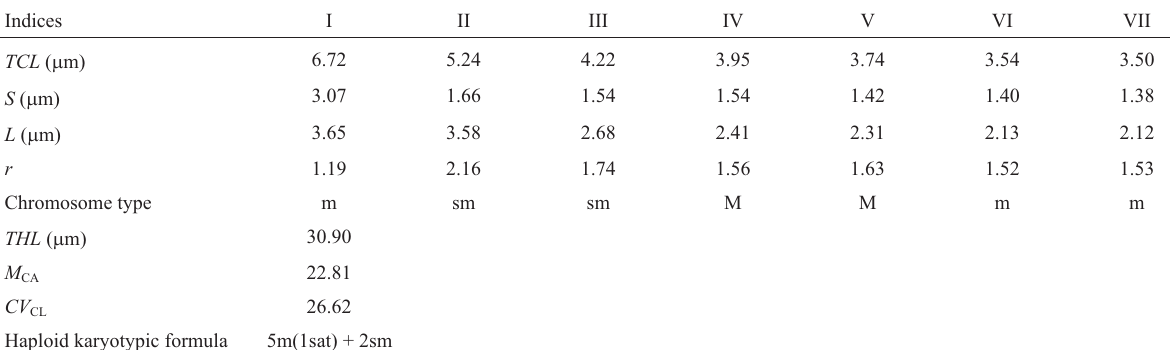
Table 6 - Karyotype features of Calydorea crocoides . Mean values of total chromosome length ( TCL ), long arm ( L ), short arm ( S ), and arm ratio ( r ). Chromosome type (m: metacentric; sm: submetacentric) total length of the haploid chromosome set ( THL ), mean centromeric asymmetry ( M CA ), coeffi- cient of variation of chromosome length ( CV CL ) and karyotypic formula.